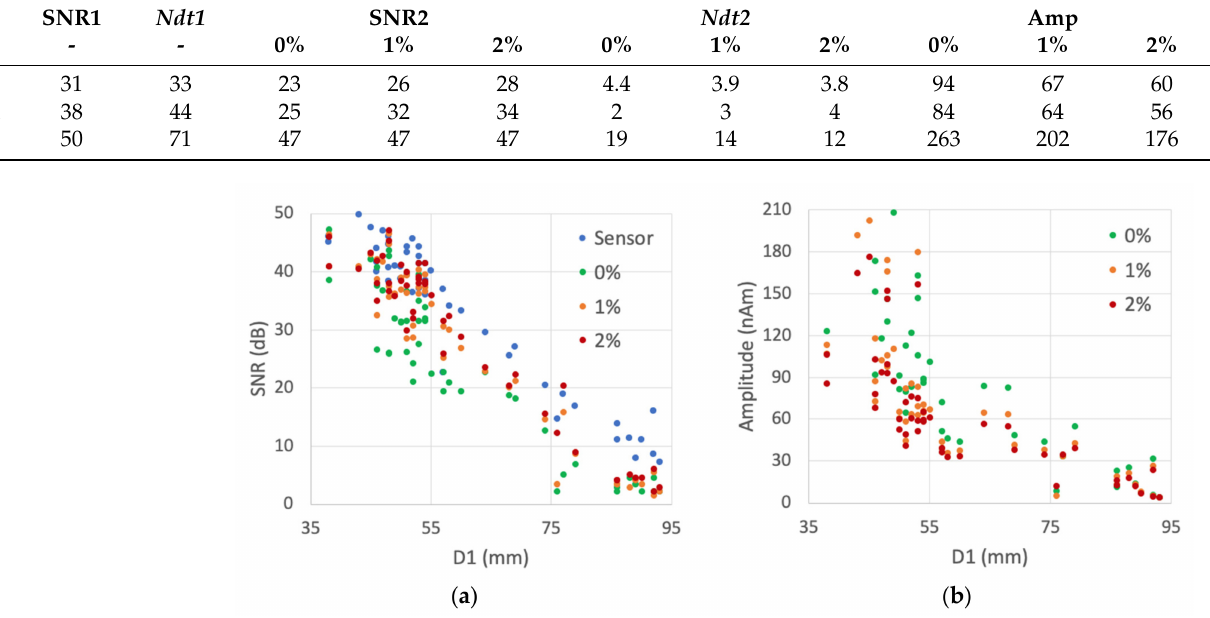
Figure 4. Simulation 2 results with three regularization values (0%, 1% and 2%). ( a ) Sensor-level SNR1 and source-level SNR2 distribution as a function of the distance D1 from the source to nearest sensor. ( b ) Source montage amplitude distribution as a function of